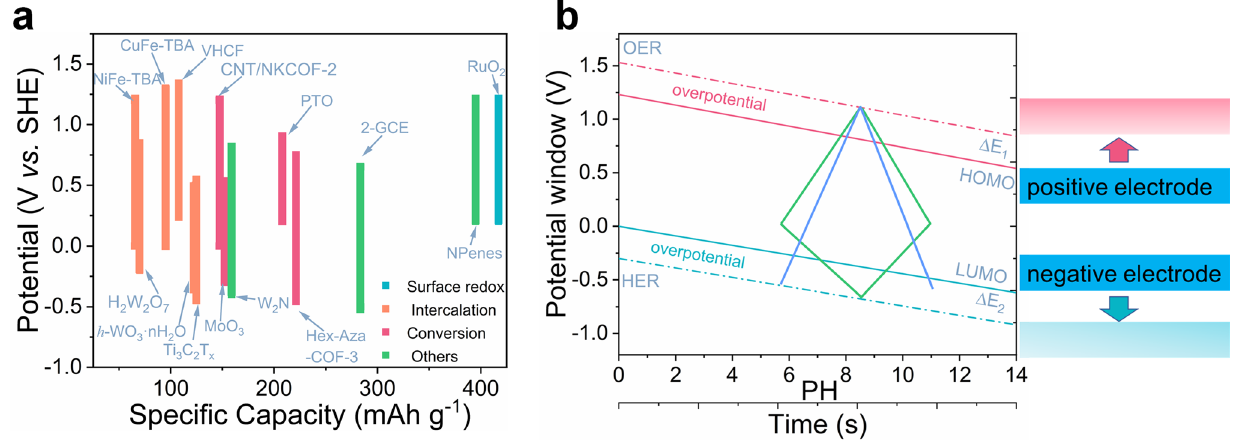
All potentials are referenced to a standard hydrogen electrode (where Ag/AgCl vs. SHE = 0.2 V, Hg/Hg 2 Cl 2 vs. SHE = 0.24 V, and Hg/Hg 2 SO 4 vs. SHE = 0.65 V). Specific capacitance is converted to specific capacity by the following equation: C =